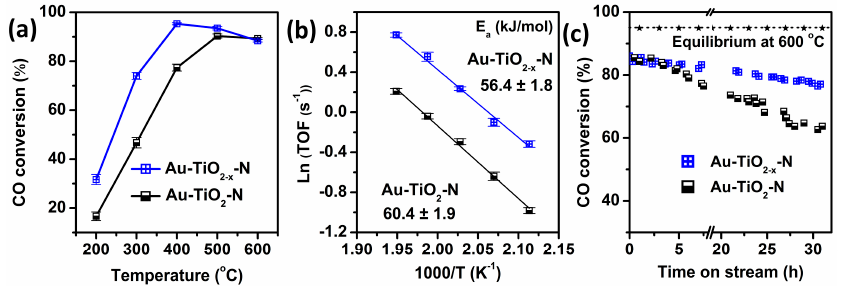
Figure 1. ( a ) The CO conversions of Au ‐ TiO 2 and Au ‐ TiO 2 − x catalysts as a function of temperature; ( b ) Arrhenius plots of TOF over Au ‐ TiO 2 and Au ‐ TiO 2 − x catalysts in the reaction temperature range of 200–240 °C; ( c ) The CO conversions at 600 °C as a function of time on stream. Dried feed gas: 12.5% CO and 87.5% N 2 .